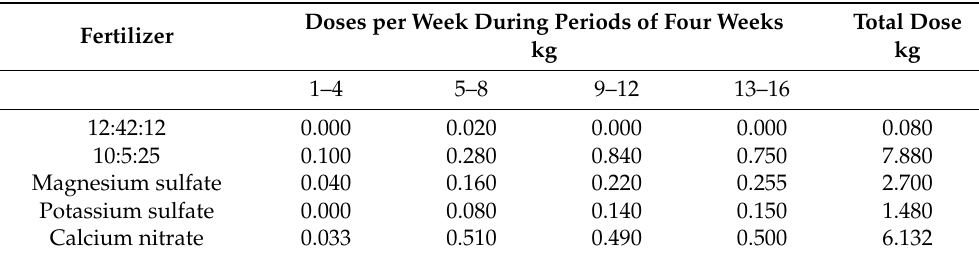
Table 1. Doses of water-soluble fertilizer applied to 56 pots during 16 weeks. The same dose schedule was applied weekly during four